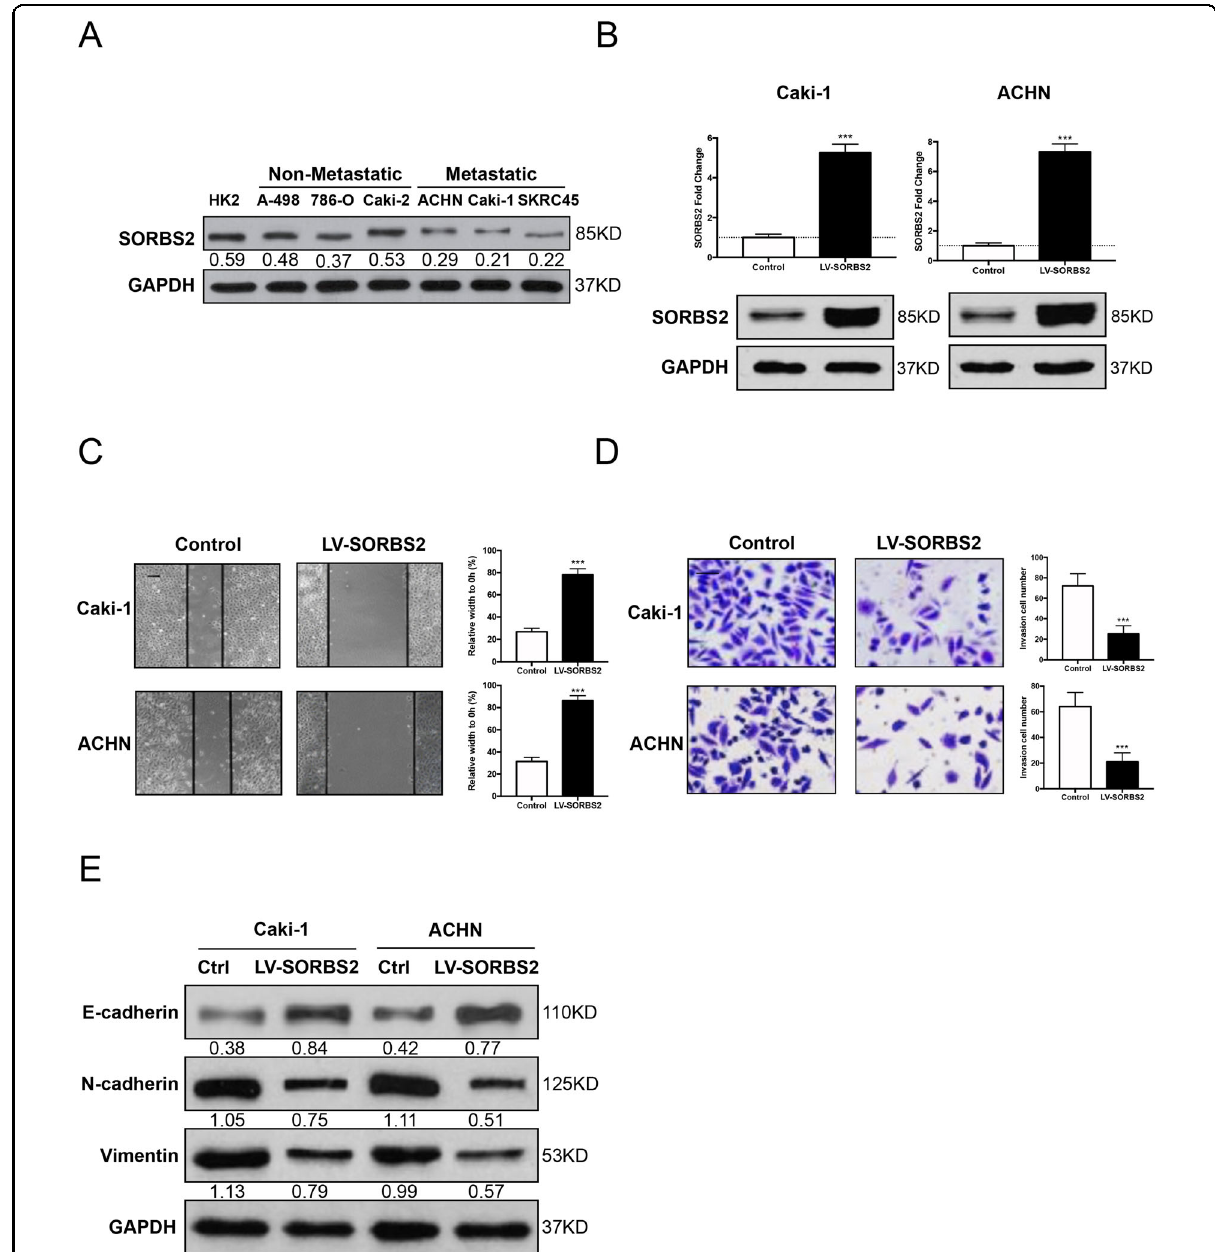
Fig. 2 SORBS2 overexpression inhibited ccRCC cell metastasis. A Western blot analysis of SORBS2 expression in ccRCC cell lines. B Western blot and qRT-PCR analysis of SORBS2-overexpression stable ccRCC cell lines. C , D Wound healing and Transwell assay, scale bar = 20 μ m. E Western blot analysis of EMT markers. *** P <